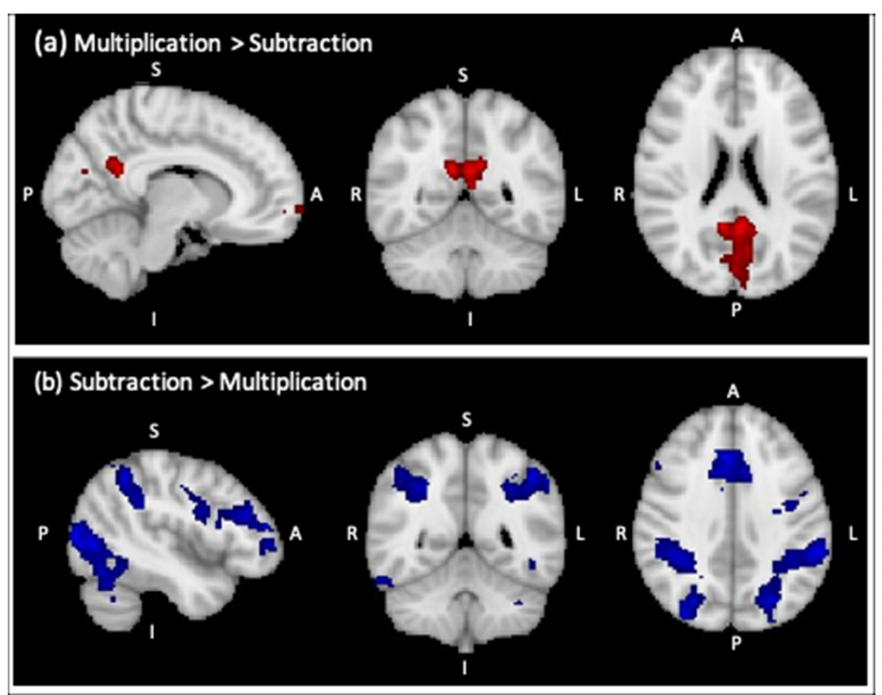
Figure A1. Regions of significant BOLD signal change for the control group (sagittal, coronal and axial view from left to right). ( a ) multiplication > subtraction (cluster threshold Z = 2.3), ( b ) subtraction > multiplication (cluster threshold Z =